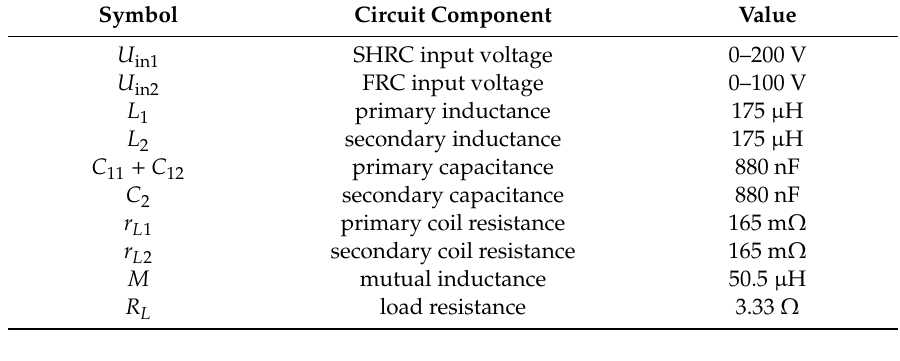
Figure 8. A 1.5 kW prototype of SHRC. Figure 9. Structure of transmitter coil. Table 1. Parameters for SHRC and FRC 1.5 kW IPT systems.